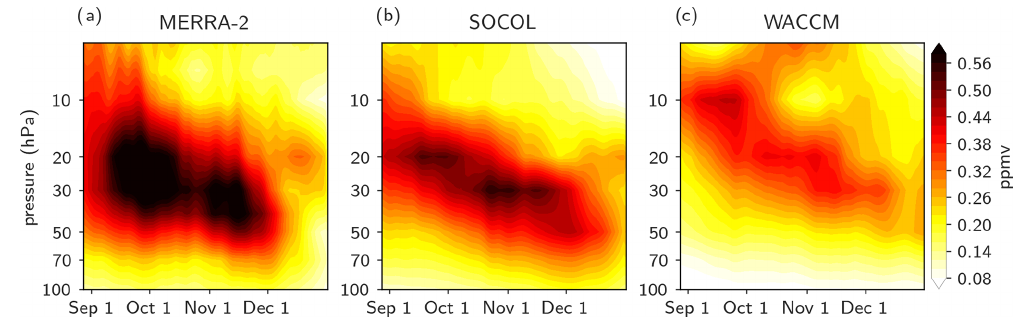
Figure A2. Ozone standard deviation in austral spring in MERRA-2 (a) , SOCOL (b) , and WACCM (c) . Table A1. Details on the timing and magnitudes of the detected weak and strong polar vortex events in MERRA-2 used in this study. Peak amplitudes are in standard deviations and refer to the SAM index at 10hPa.